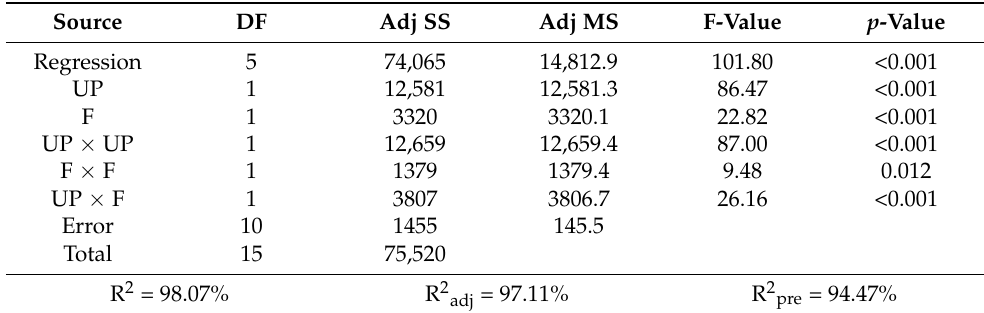
Table 7. Variance analysis of wear volume.